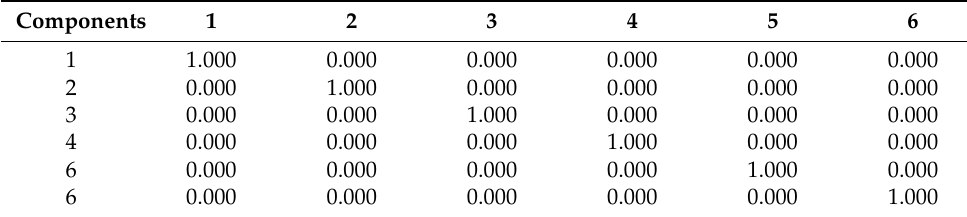
Table A5. Variance-covariance matrix of factor